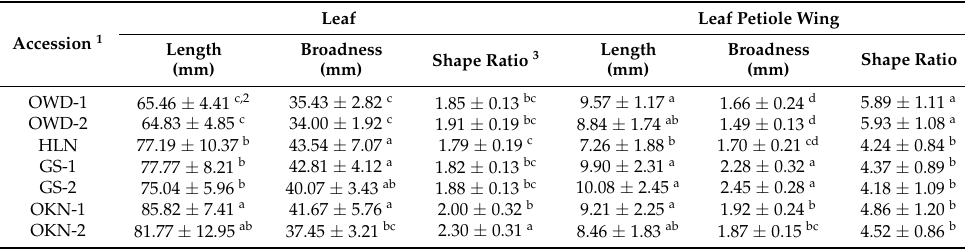
Table 1. Leaf characteristics of Taiwanese accessions of Citrus depressa